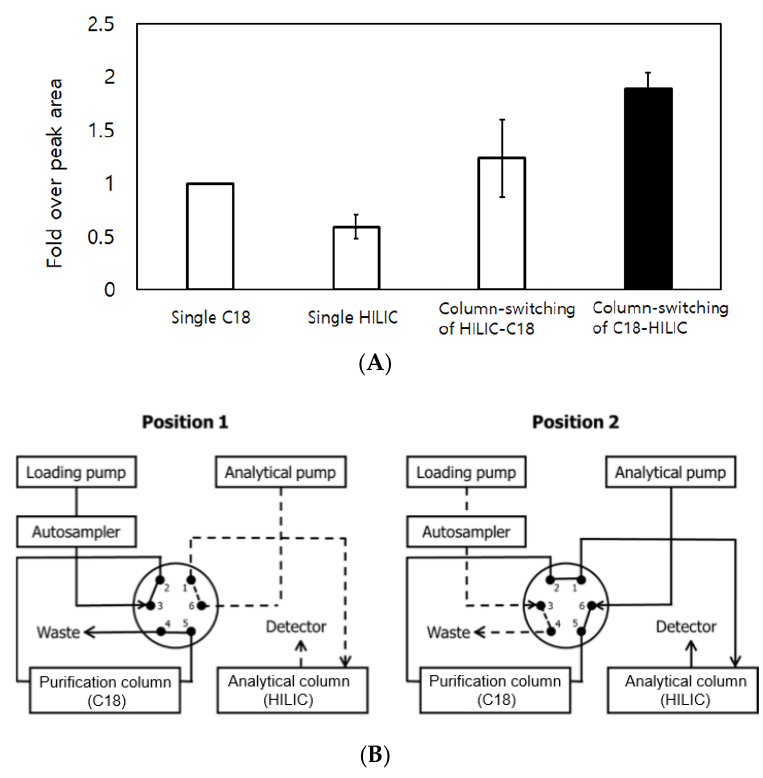
Figure 1. Comparison of peak areas of EtG by different modes of separation (( A ), n = 3; mean ± standard deviation) and the schematic of the column-switching HPLC system used in the current study ( B ).